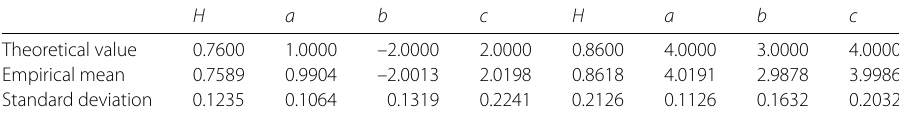
Table 3 The means and standard deviations of the estimators with N = 1200